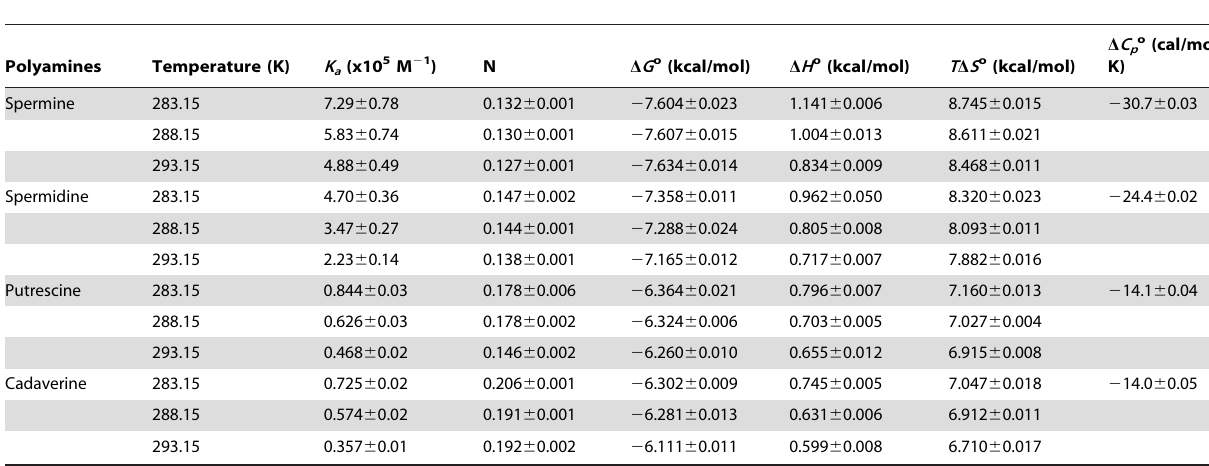
Table 2. ITC derived thermodynamic parameters for the binding of polyamines to EC DNA a .